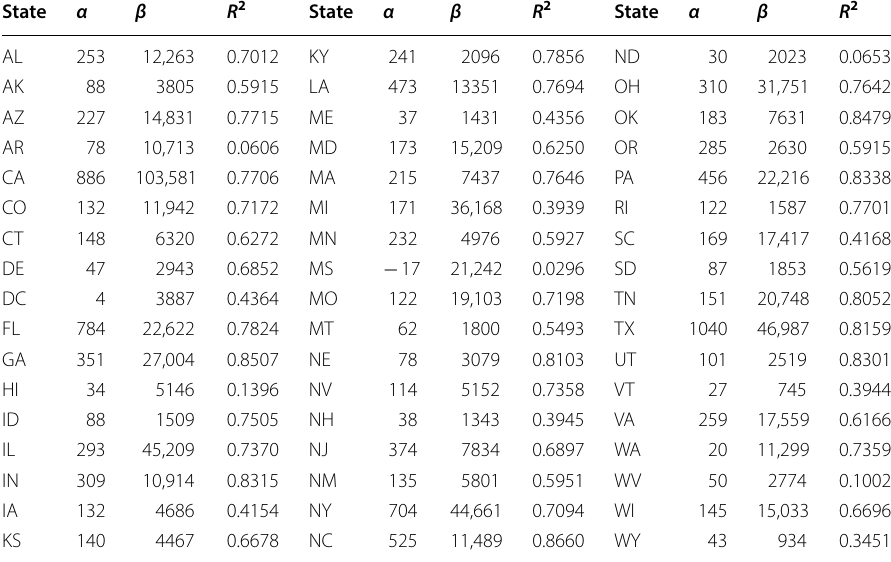
Table 2 Coefficients α , β , and R 2 of the linear regressions for Chlamydia cases